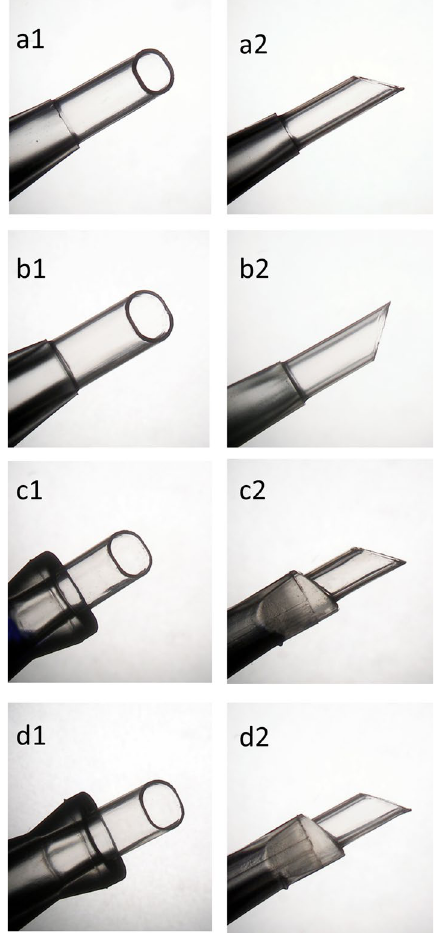
Figure 3. Representative microscopic images of 4 unused IOL injector systems. ( a1 , a2 ) Axial view and profile view of Monarch III D Cartridge. ( b1,b2) Axial view and profile view of AcrySert C. ( c1,c2 ) Axial view and profile view of UltraSert. ( d1,d2 ) Axial view and profile view of